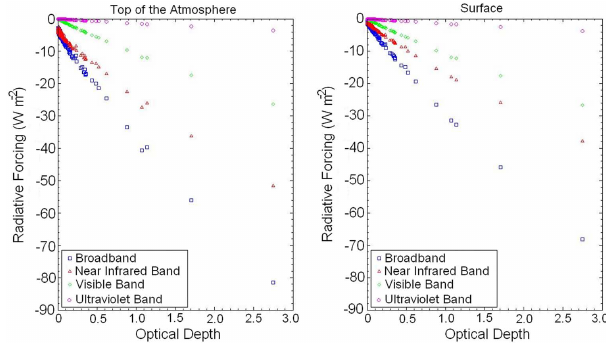
Fig. 5. Relation between daily mean value of SCRF, both for the broadband and the spectral bands of solar radiation, and the cirrus optical depths, for all dataset.